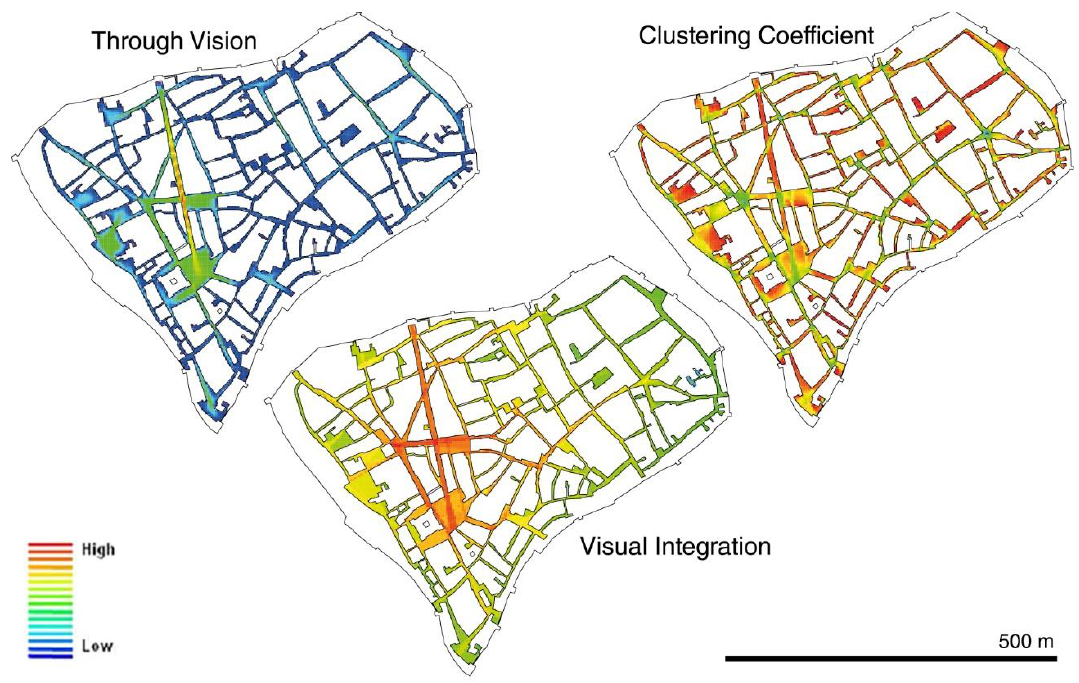
Figure 12 VGA Norcia city centre. Through Vision, Visual Integration, Clustering